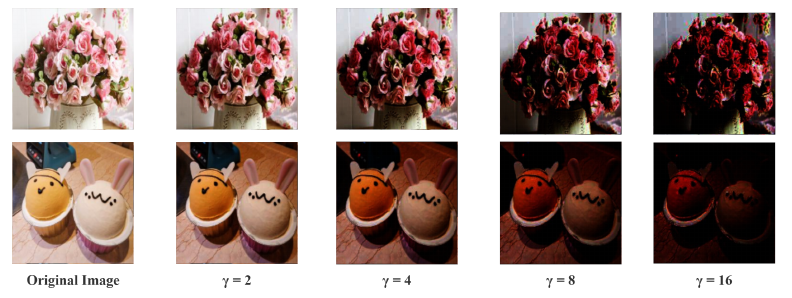
Figure 4. Low-light images are synthesized from bright images using different parameters γ